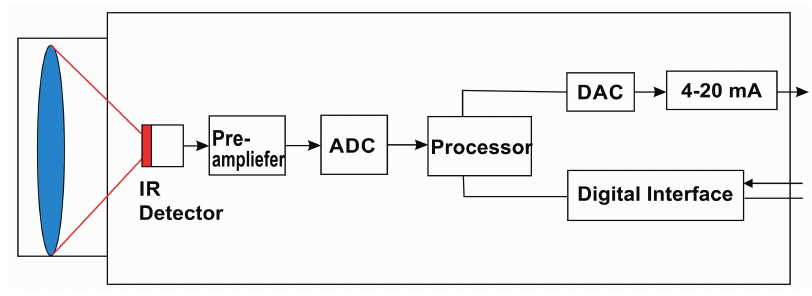
Figure 4. Block diagram of an IR